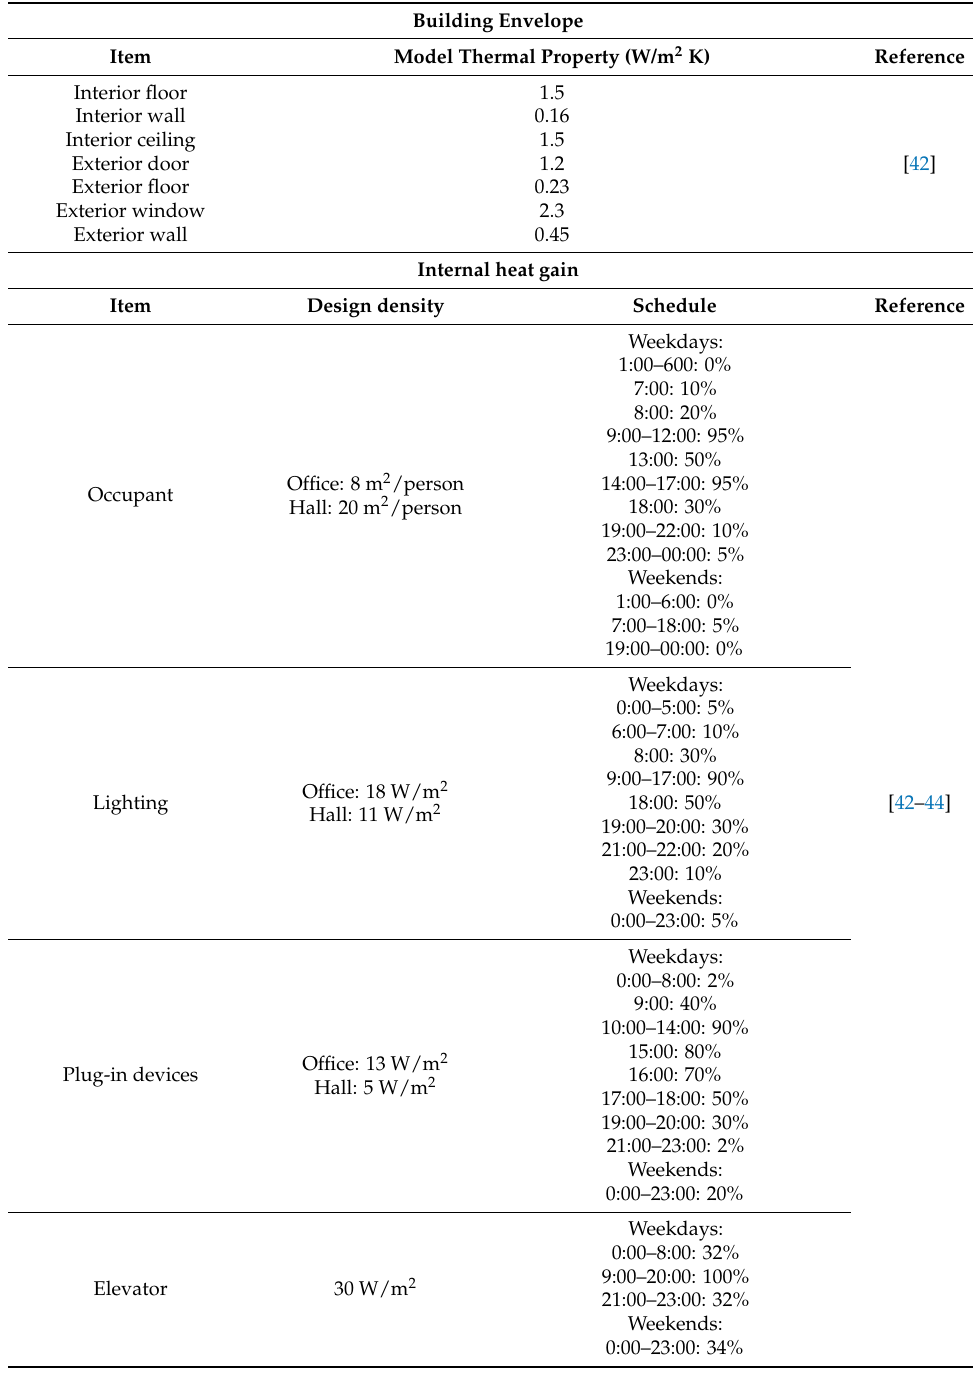
Table 1. The related parameter settings in the